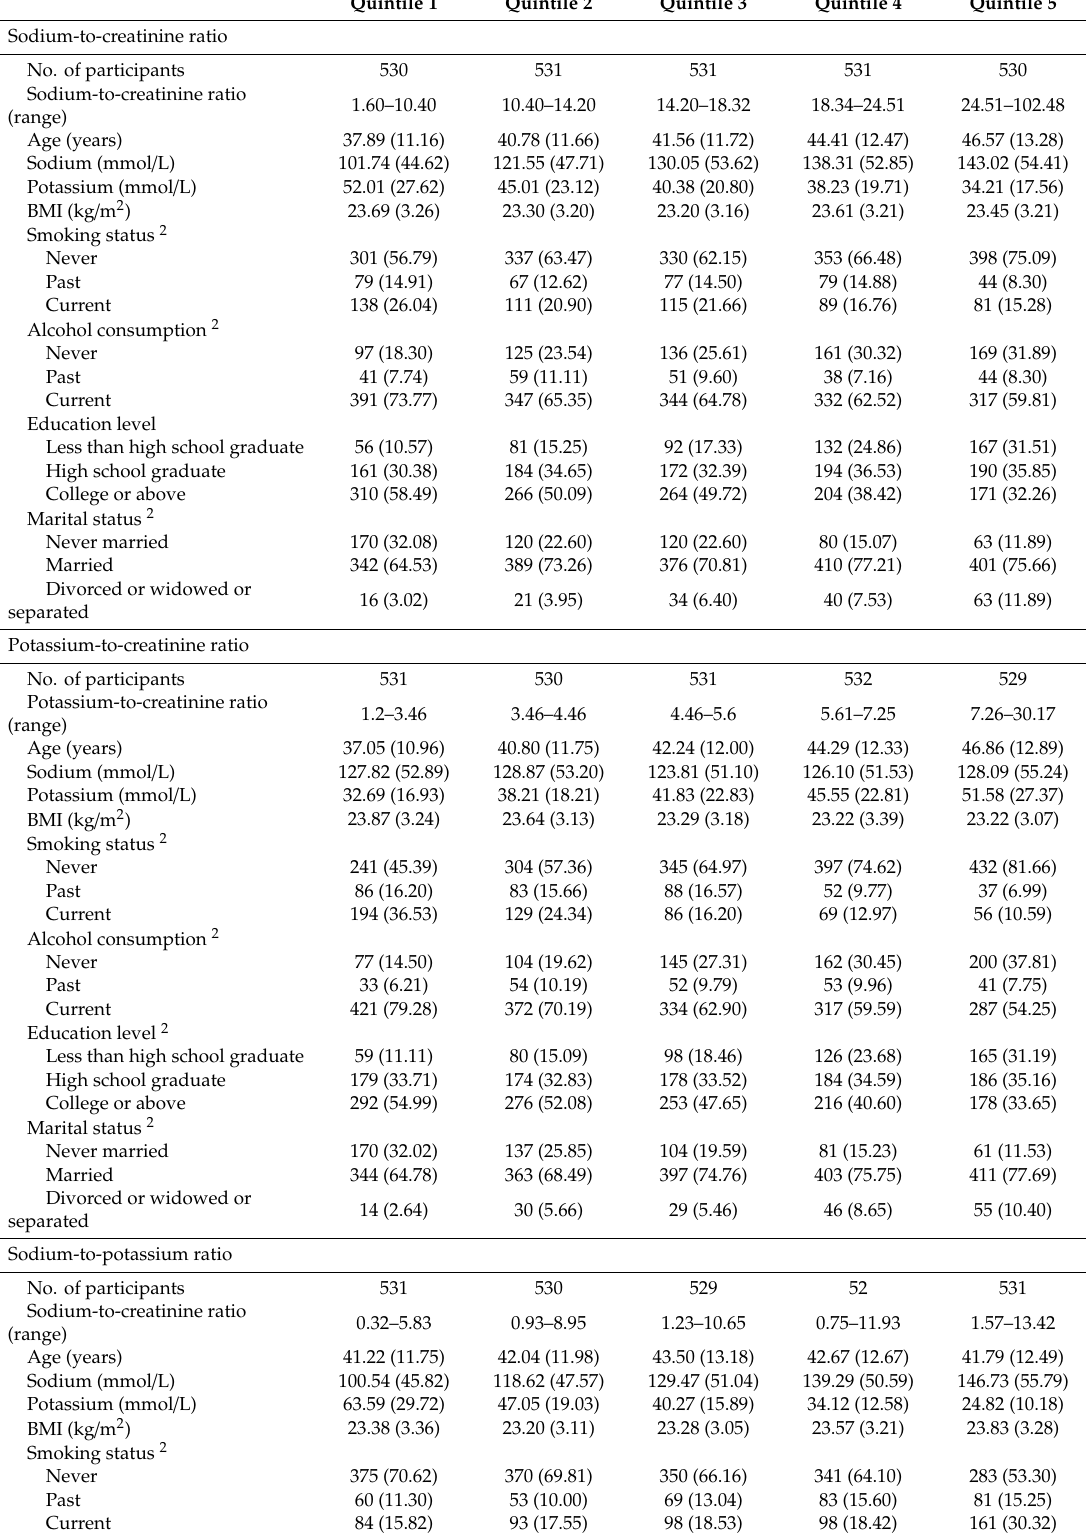
Table 1. Baseline characteristics according to the sodium-to-creatinine ratio, potassium-to-creatinine ratio and sodium-to potassium ratio in men and women combined